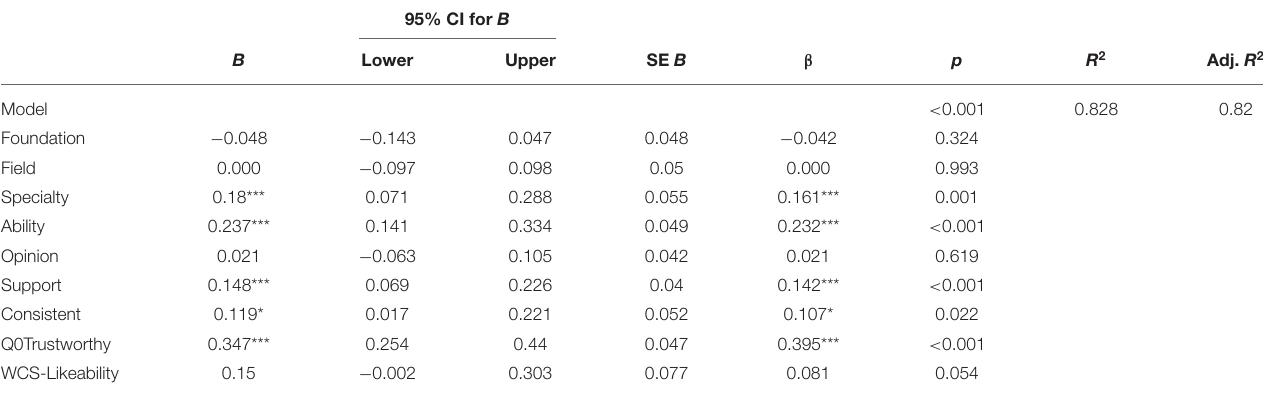
TABLE 3 | Multiple regression predicting persuasiveness from continuous expert persuasiveness expectancy (ExPEx) ratings and witness credibility score (WCS) for likeability.